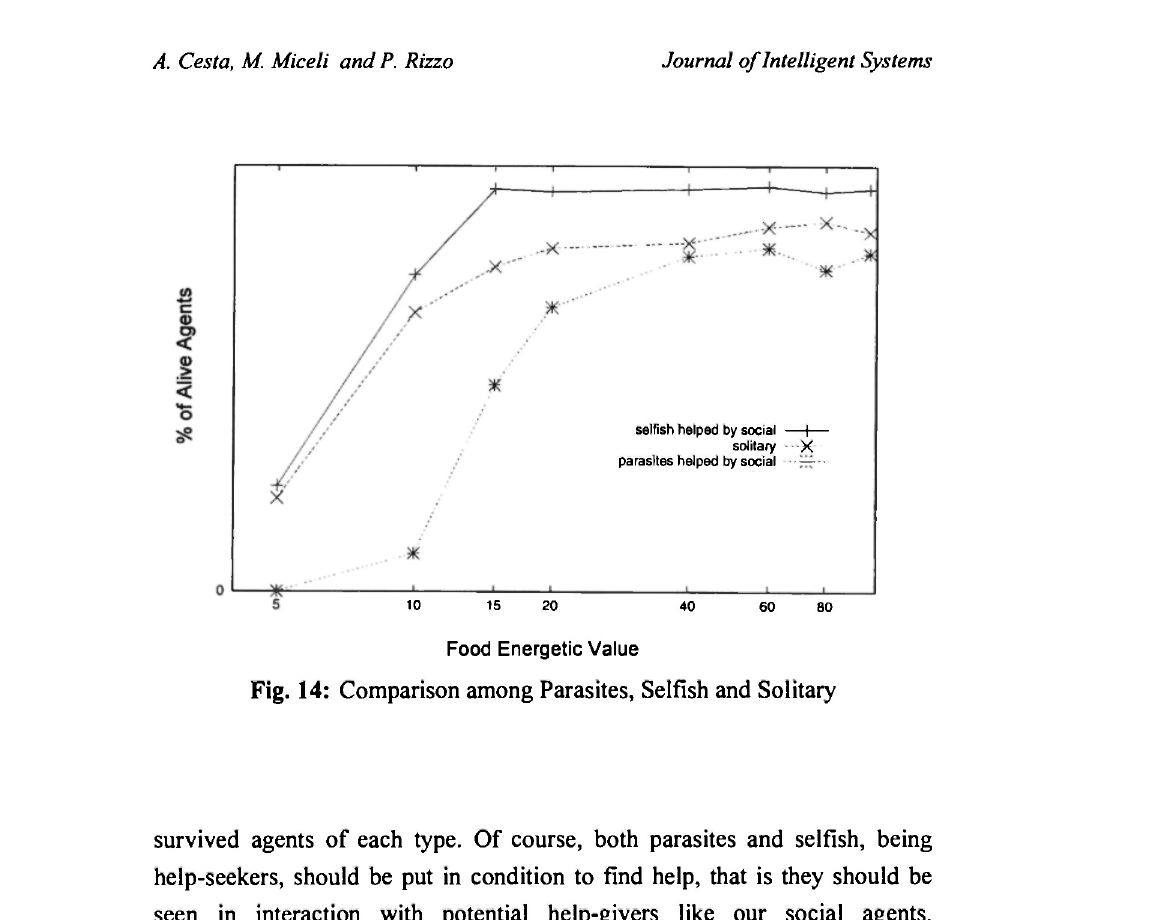
Fig. 14: Comparison among Parasites, Selfish and